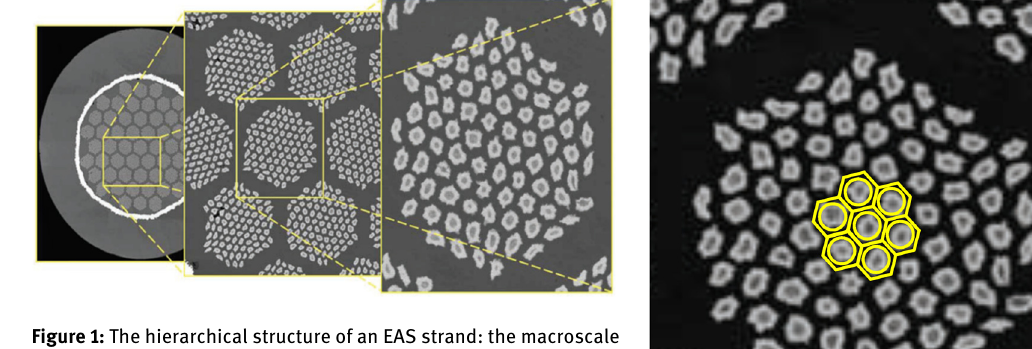
Figure 1: The hierarchical structure of an EAS strand: the macroscale structure of the global strand ( Left ) , the mesoscale structure of the fi lament groups ( Center ) , and the microscale structure of the fi lament ( Right ) . ( Reprinted from ref. [ 13 ] , with copyright permission from Elsevier ) .